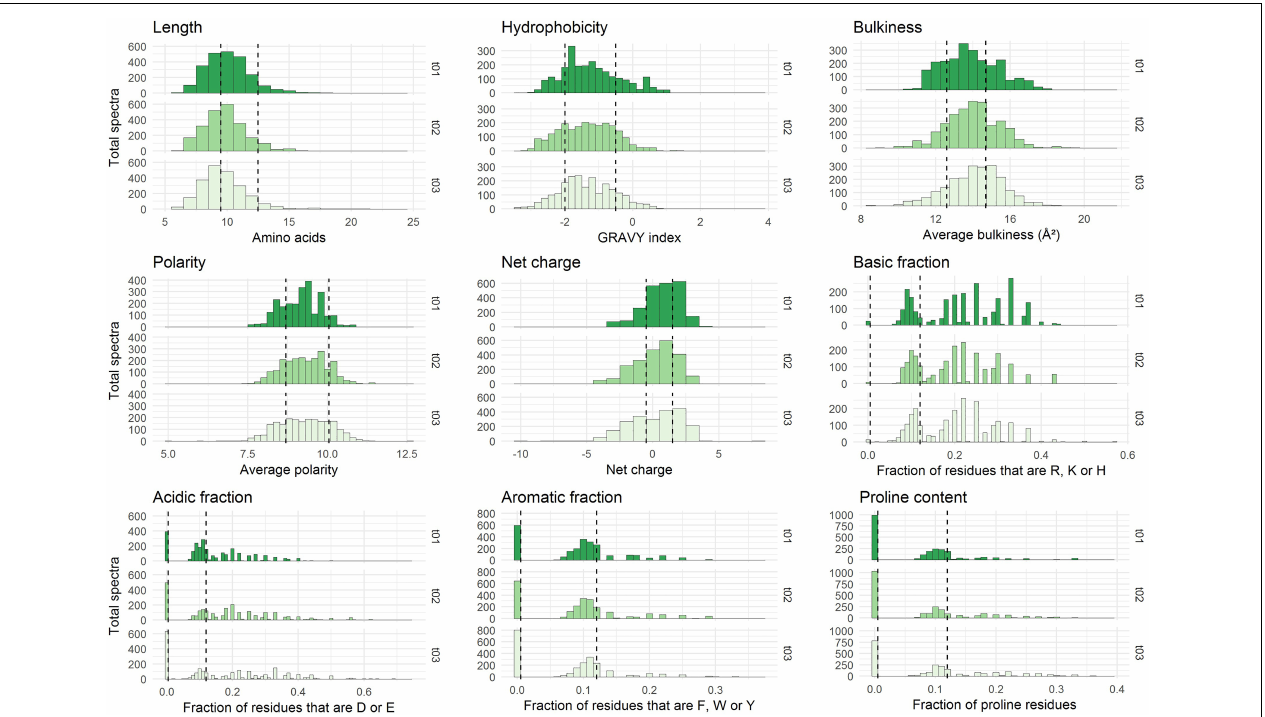
FIGURE 2 | Physicochemical properties of the peptides initially present in YE before inoculation ( t = 0 h). The three repetitions are represented separately. The x-axes correspond to the scales specific to each physicochemical property. The y-axes represent the number of spectra observed. Vertical dashed lines indicate the limits chosen for the definition of the intervals used for peptide barcoding ( Table 1 ). As peptide length, hydrophobicity, bulkiness, polarity, and net charge show a bell-shaped distribution, the limits were chosen so that they framed the profile peak. The remaining properties correspond to frequencies of specific types of residues in the peptide amino acid composition. The first limit defines the “zero sub-class”: absence of the considered residues in the peptide composition, and the second limit was arbitrarily fixed at 12%.